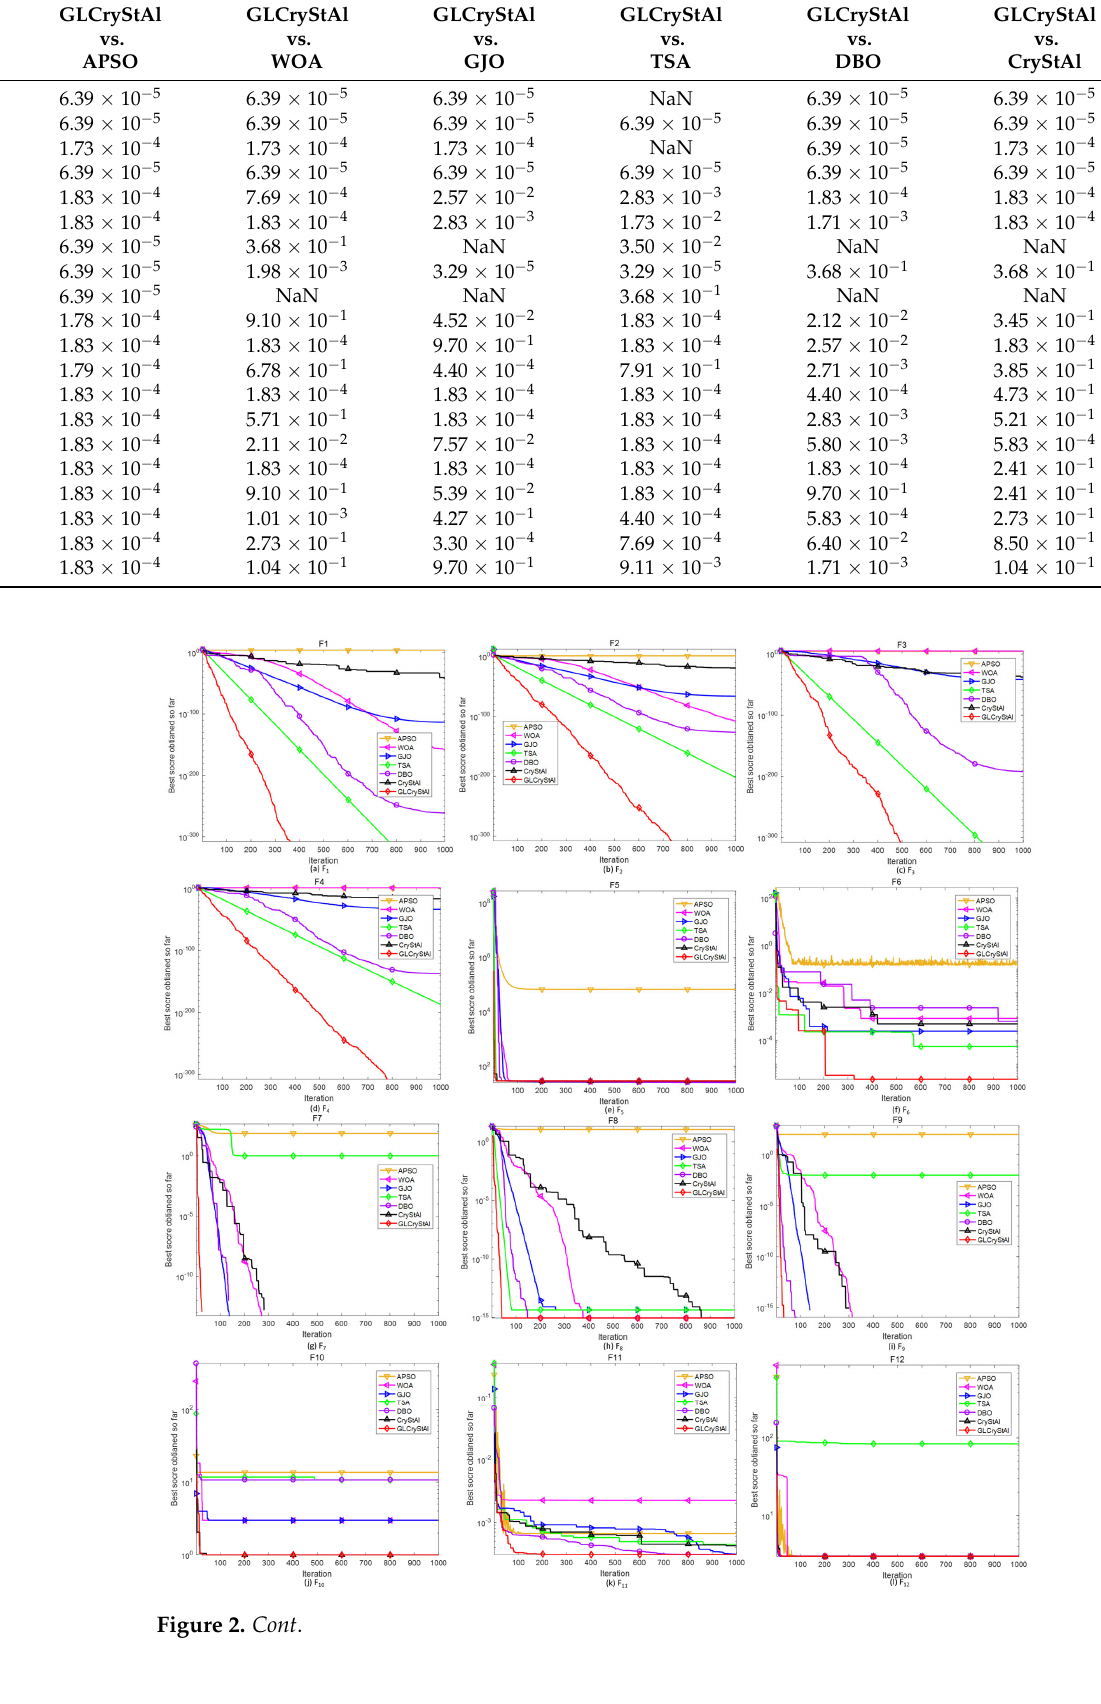
Table 7. p -value of Wilcoxon statistical test results.